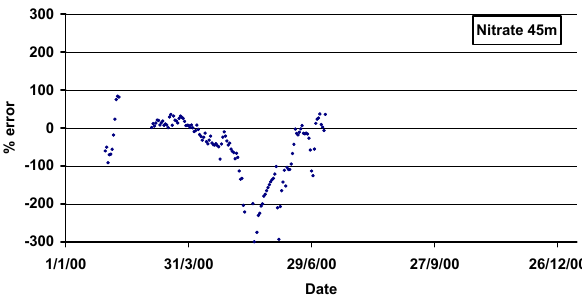
Fig. 11. The percentage error (100*(Data-Model)/Data) for nitrate at